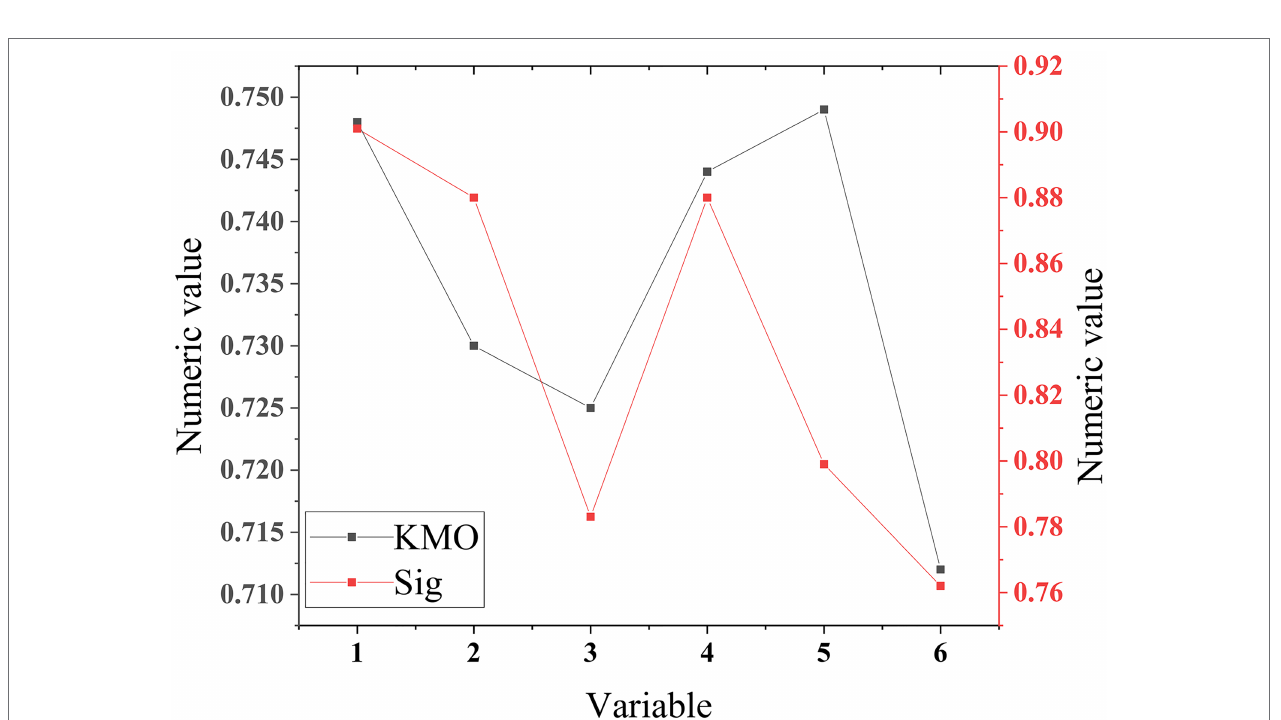
FIGURE 6 | Kaiser-Meyer-Olkin test of the